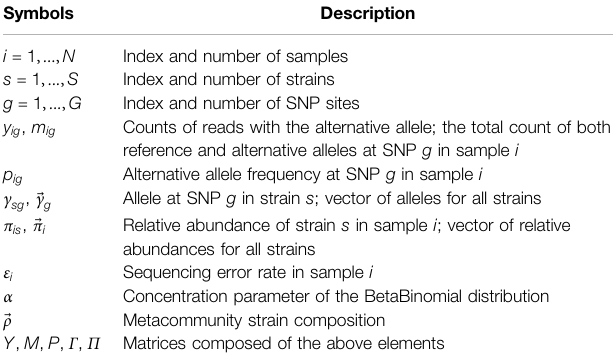
TABLE 1 | Symbols used to describe the StrainFacts model. Symbols